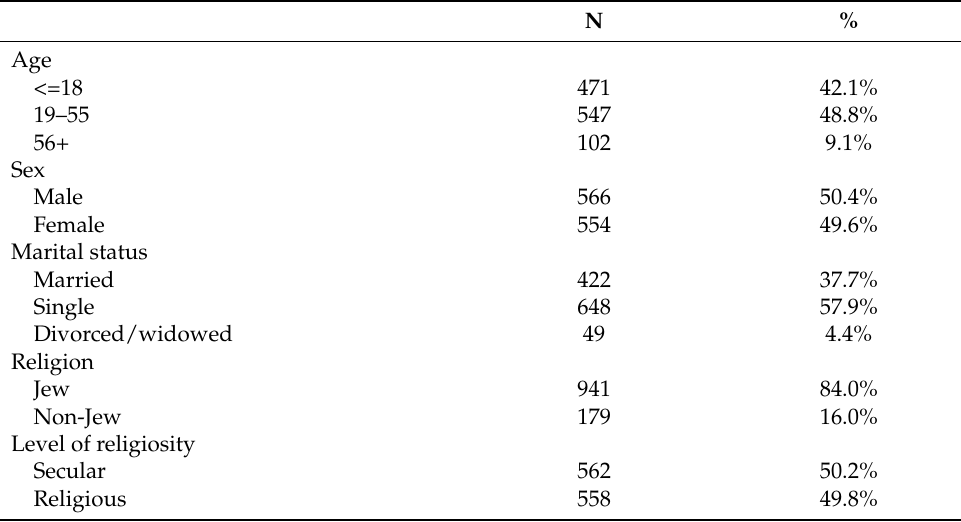
Table 1. Study population, n =